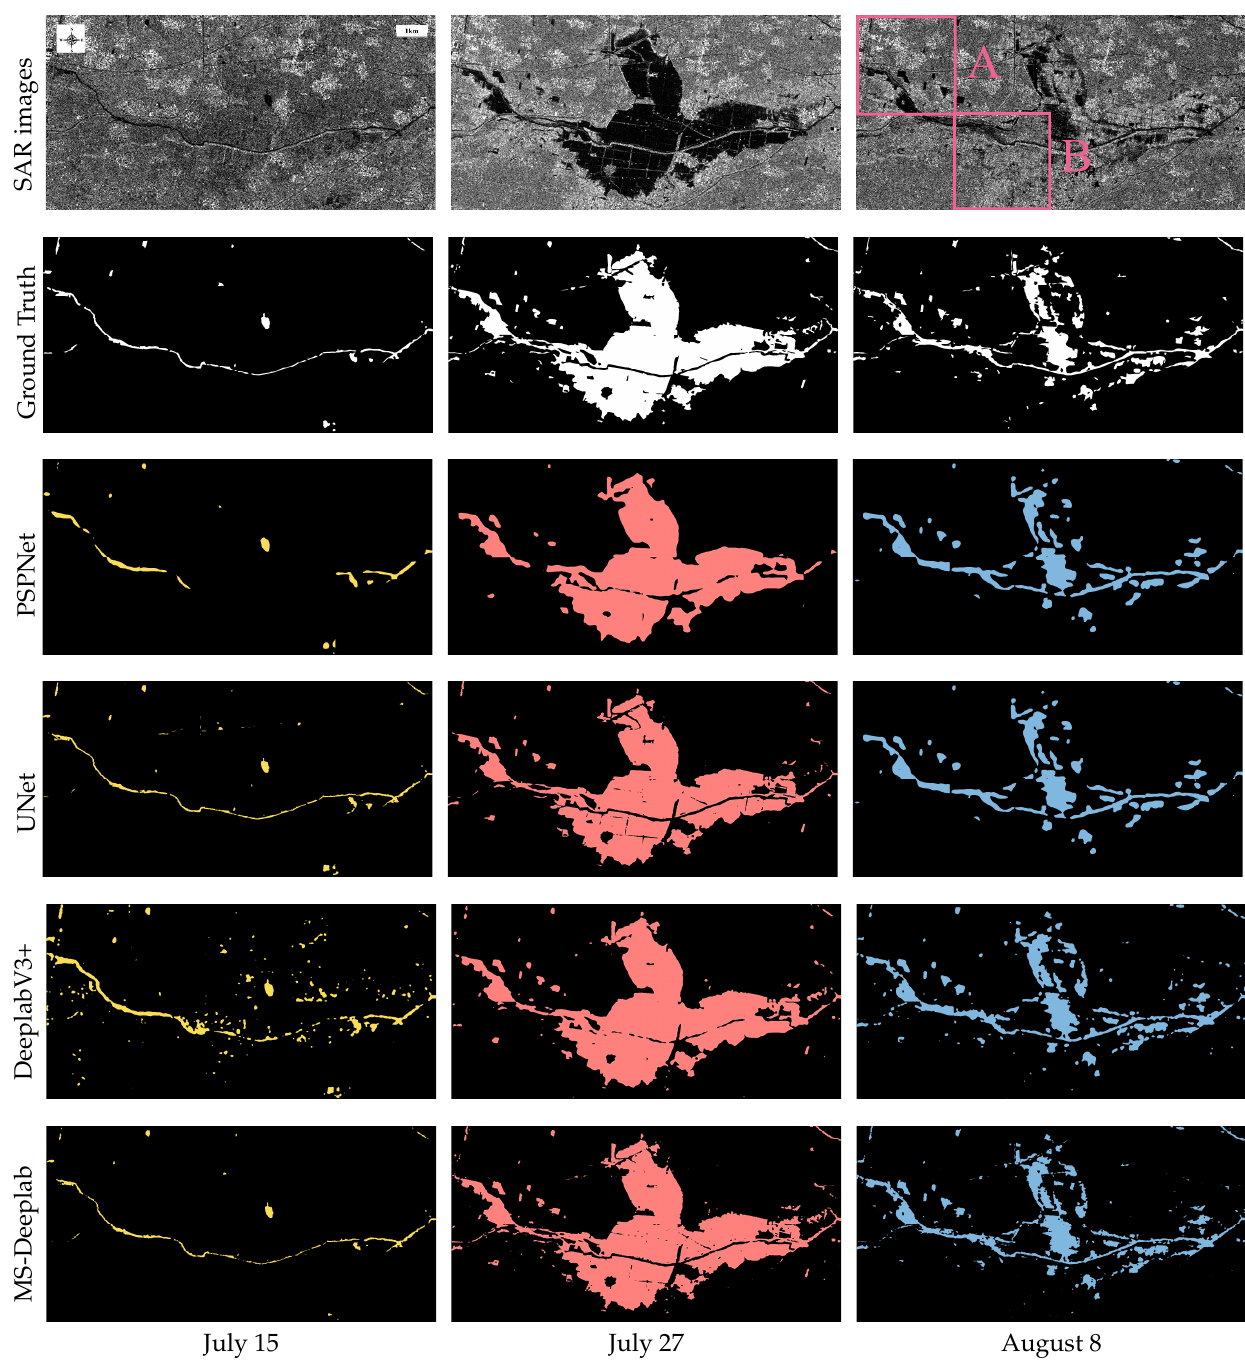
Figure 9. Time series of SAR images and segmentation results of the area near Anyang River. The first row is the time series of SAR images. The second row is the ground truth. The third row is the segmentation results generated by PSPNet. The fourth row is the segmentation results generated by UNet. The fifth row is the segmentation results generated by DeeplabV3+. The sixth row is the segmentation results generated by the proposed MS-Deeplab